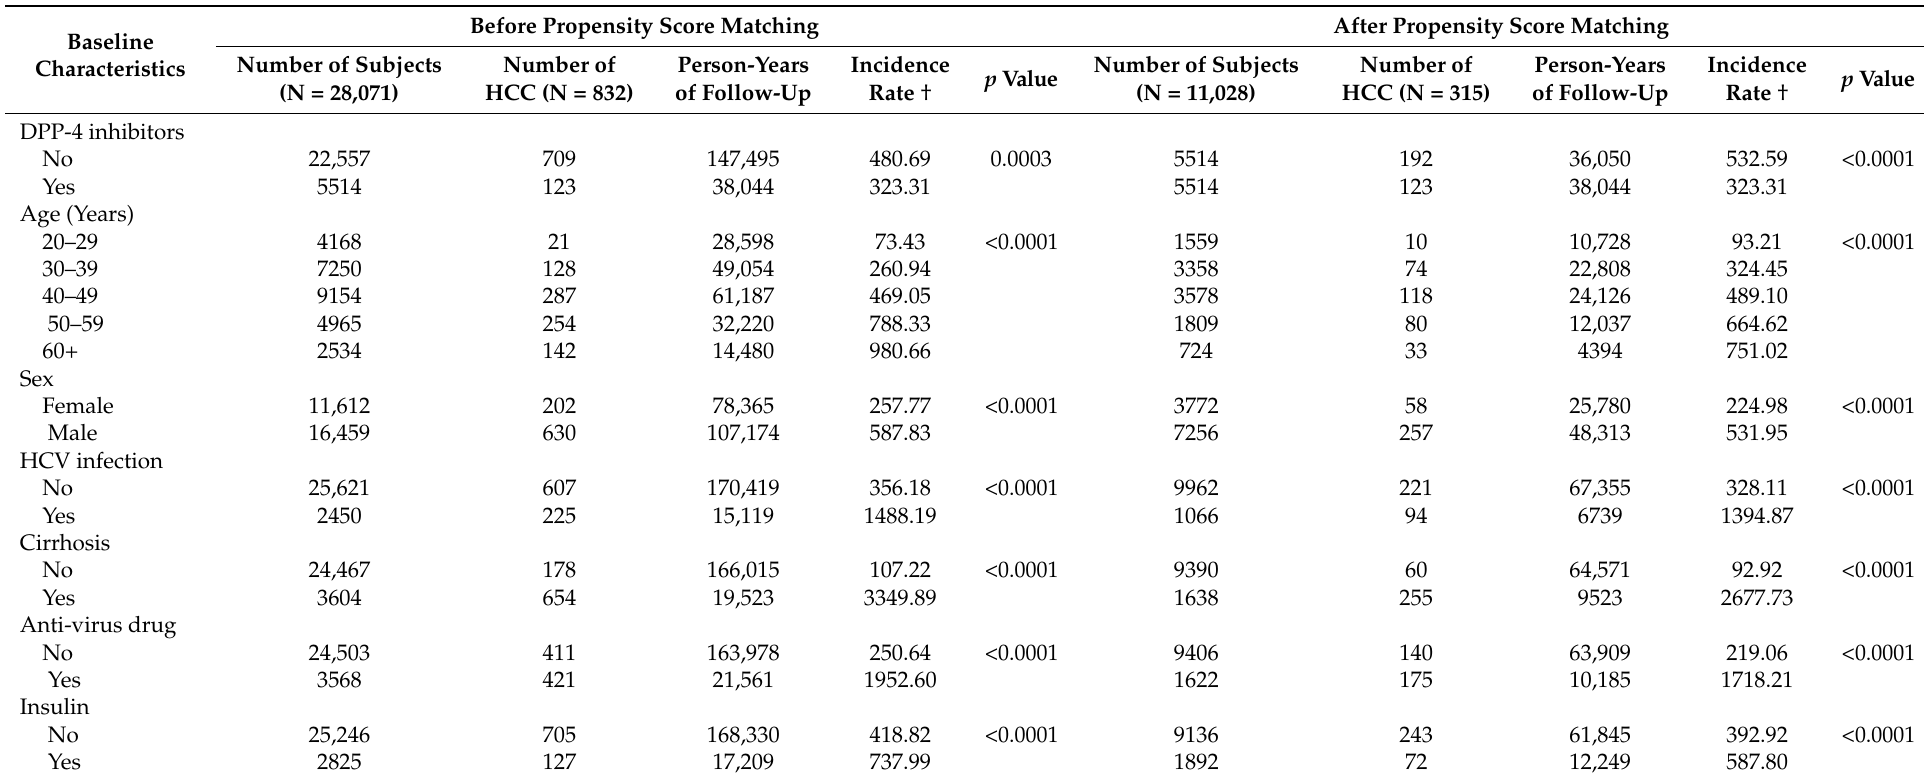
Table 2. Numbers of subjects and incidence of hepatocellular carcinoma by baseline characteristics before and after propensity score